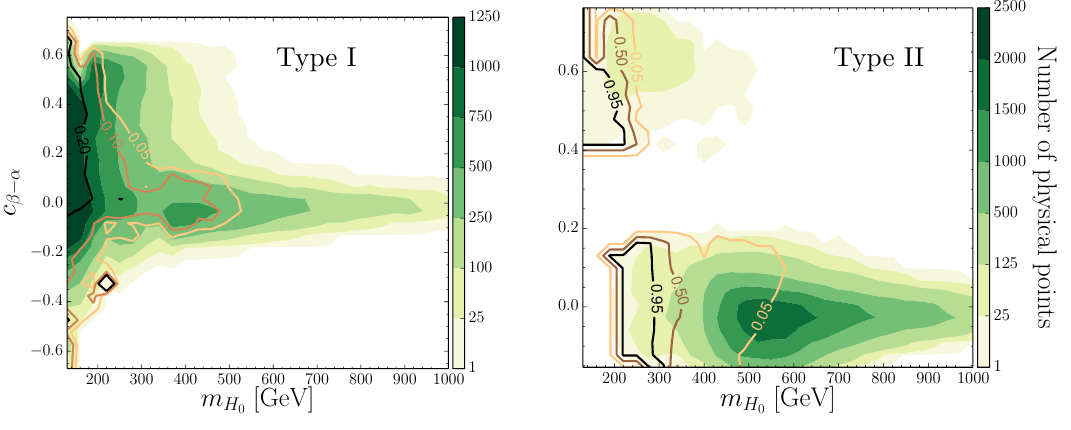
contours in the ( m H ; c (cid:12) (cid:0) (cid:11) ) 0 P (cid:24)> 1